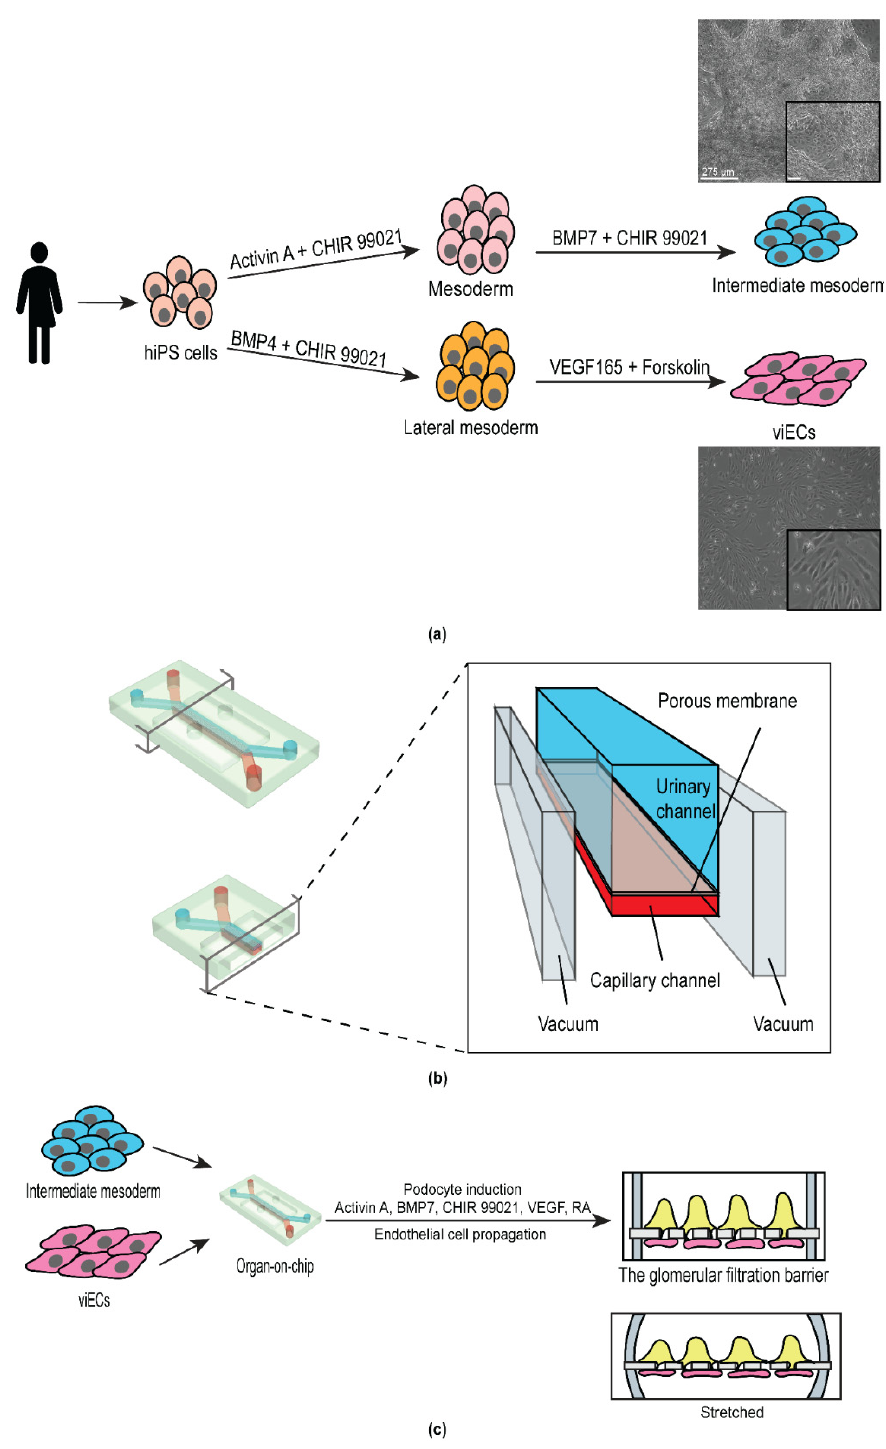
Figure 1. Schematic of the experimental strategy for engineering a personalized glomerulus chip. ( a ) Derivation of intermediate mesoderm and vascular induced endothelial cells from human induced pluripotent stem cells derived from a single individual. Images on the right are representative bright field images of intermediate mesoderm (top) and vascular induced endothelial cells (bottom). Scale bar 275 µ m. Inset scale bar: 90 µ m; ( b ) Anatomy of the glomerulus chip. Lower left panel, cross-sectional view of the chip. Right panel, channel anatomy of the chip; and ( c ) Incorporation of iPS cell-derived intermediate mesoderm and endothelial cells into the urinary and the microcapillary channel of the chip, respectively and subsequent differentiation of mature human podocytes from intermediate mesoderm cells. Upper right panel, cross-sectional view of the cell-embedded glomerulus chip. Lower right panel, cross-sectional view of the cell-embedded glomerulus chip under